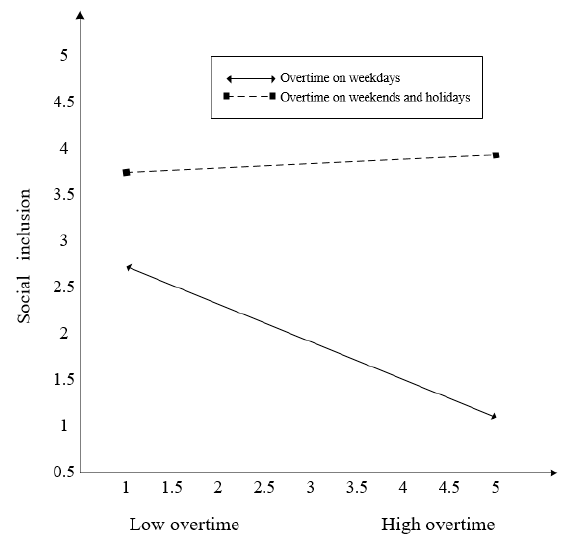
Figure 3. The moderating effect of time type between overtime and social inclusion.